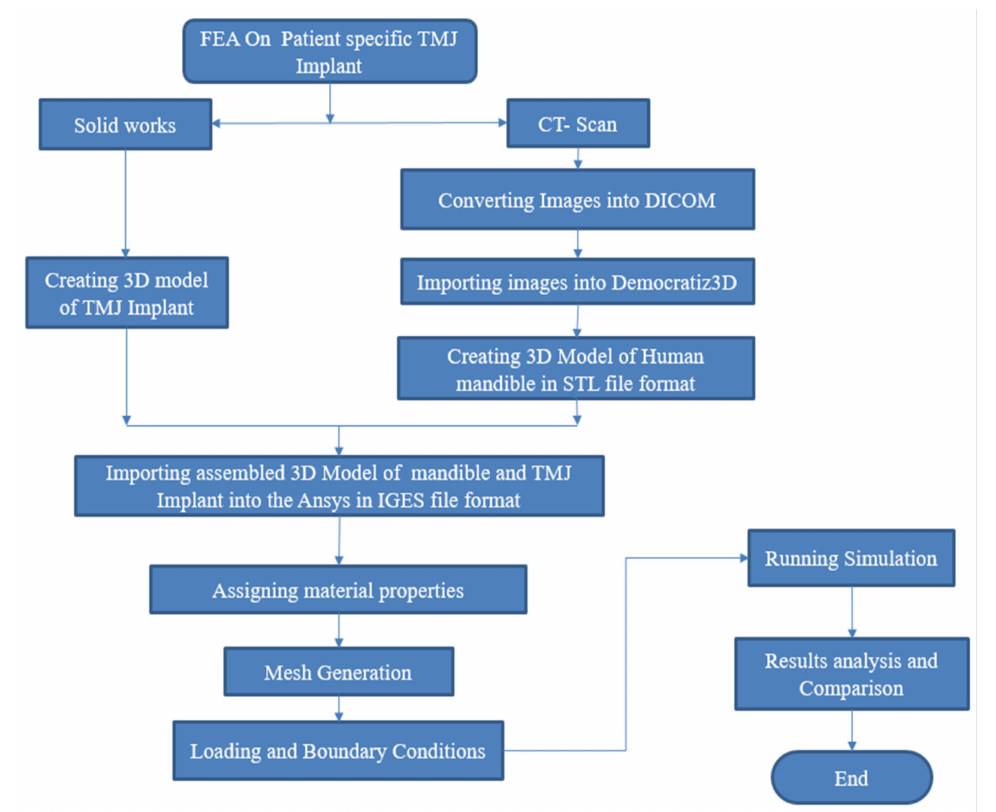
Figure 2. Flow chart of finite element analysis of patient-specific TMJ